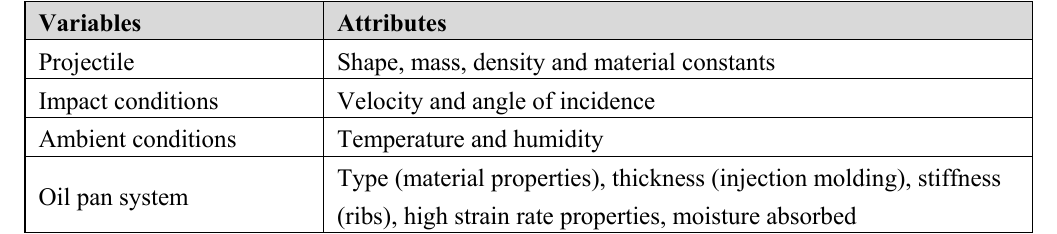
Table 1. Stone impact